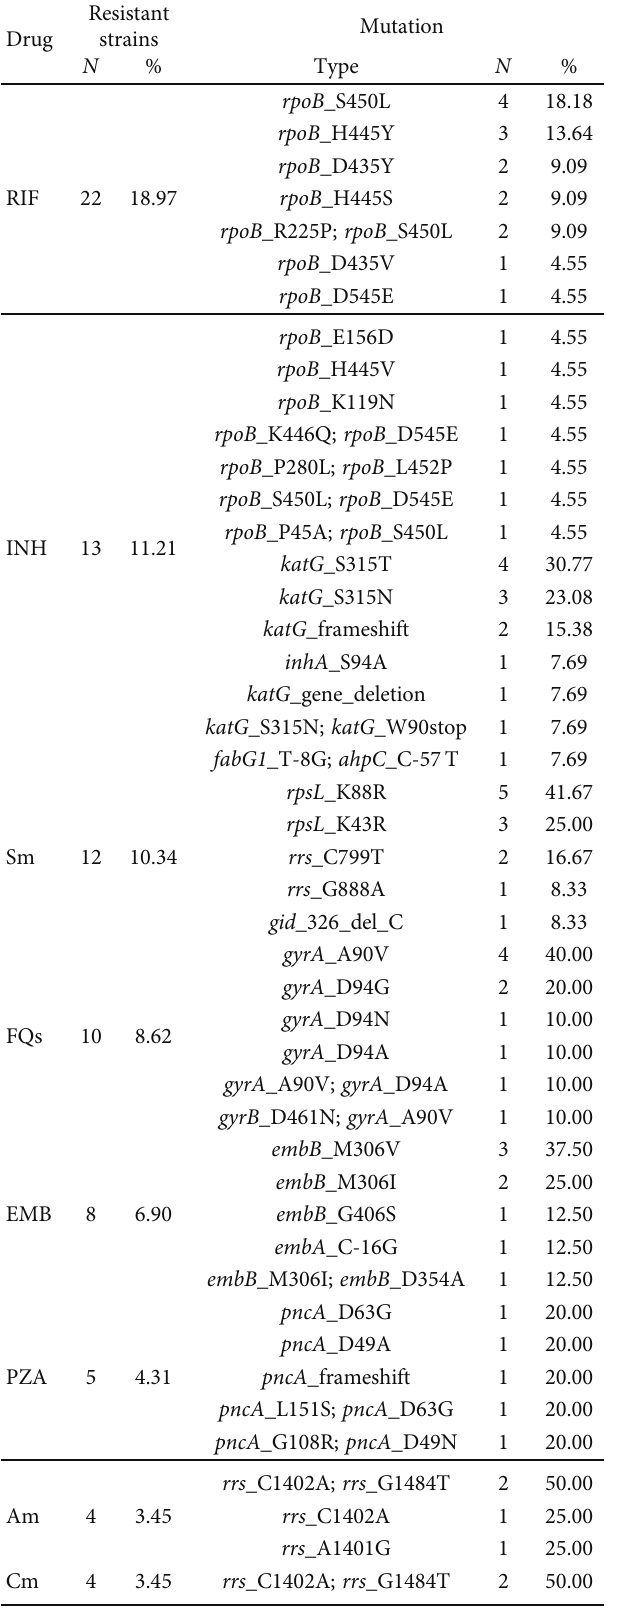
Table 2: Drug resistance and gene mutation type in 116 strains. Drug